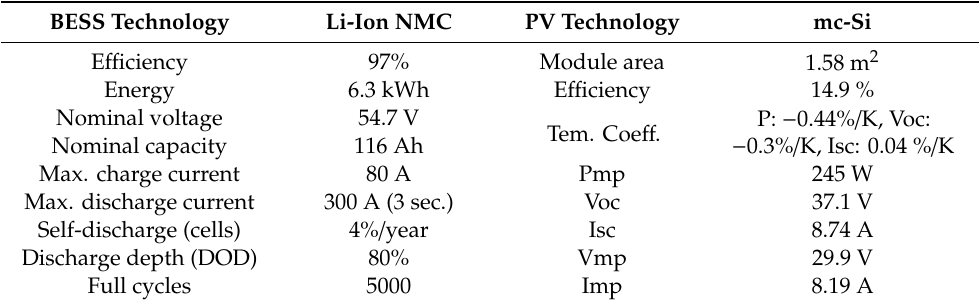
Table 2. PV and battery energy storage system (BESS) main